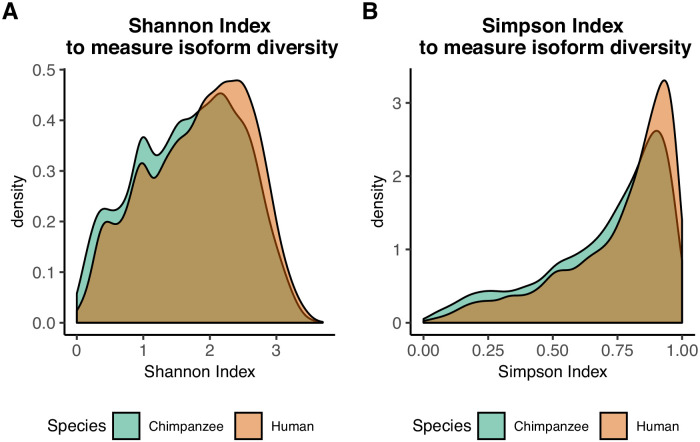
Information content measurement densities.(A) Density of Shannon indices for all tested genes in human and chimpanzee −∑i=1spilog2⁡Pi. (B) Density of Simpson indices for all tested genes in human and chimpanzee −∑i=1spi2.